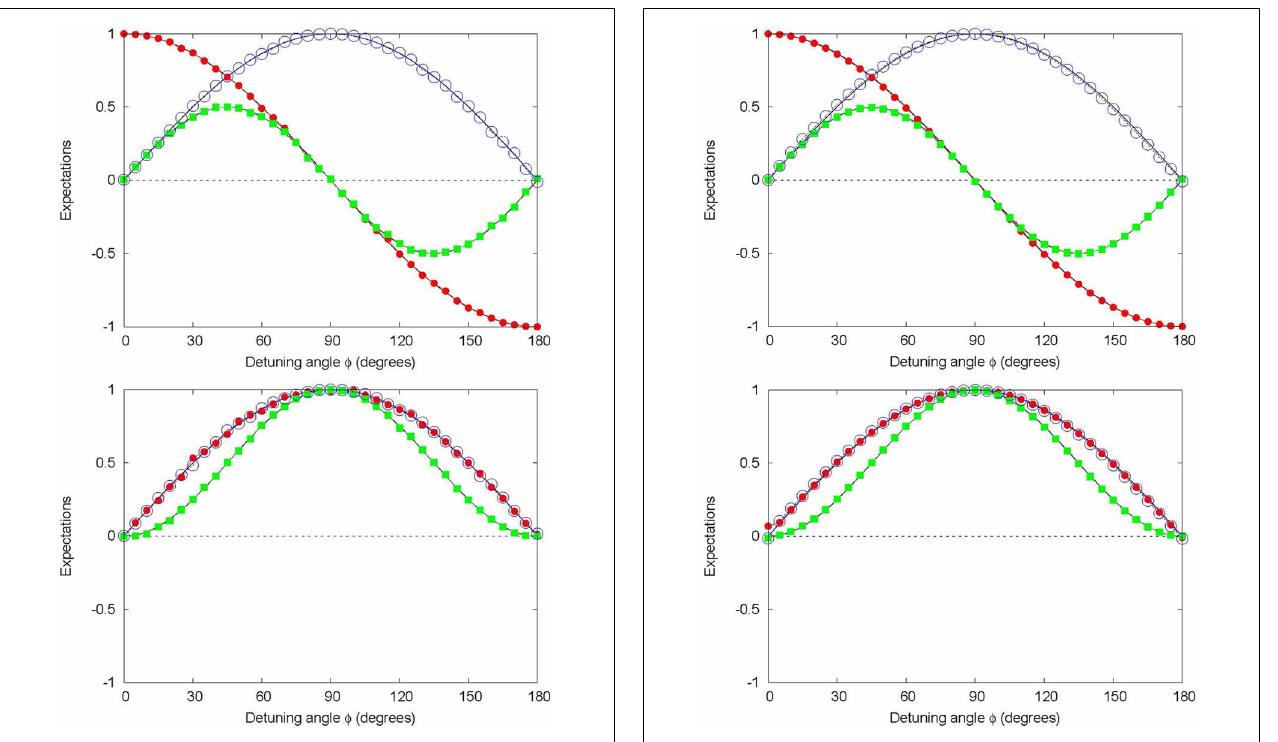
FIGURE 4 | Same as Figure 3 except that the probabilistic model for the spin-analyzer, as specified by Equation (18), has been replaced by a deterministic learning machine with an update rule given by Equation (19). For each pair of settings ( S 1 , S 2 ) of the spin analyzers (SA2,SA3) and each position of the pair of spin flippers (SF2,SF3) represented by a rotation of φ about the z -axis, referred to as detuning angle in Erhart et al. [14], Sulyok et al.[15], the simulation consists of sending N = 10000 messengers (“neutrons”) into stage 2. The parameter γ = 0 .